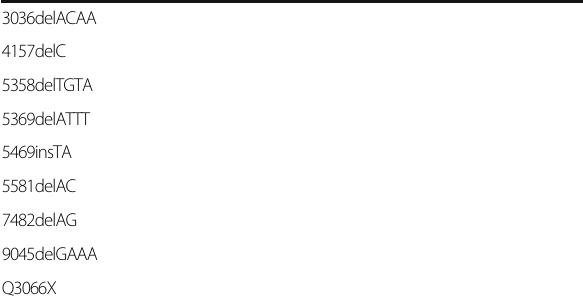
Table 7 Most of the BRCA2 mutations variants detected within African literature